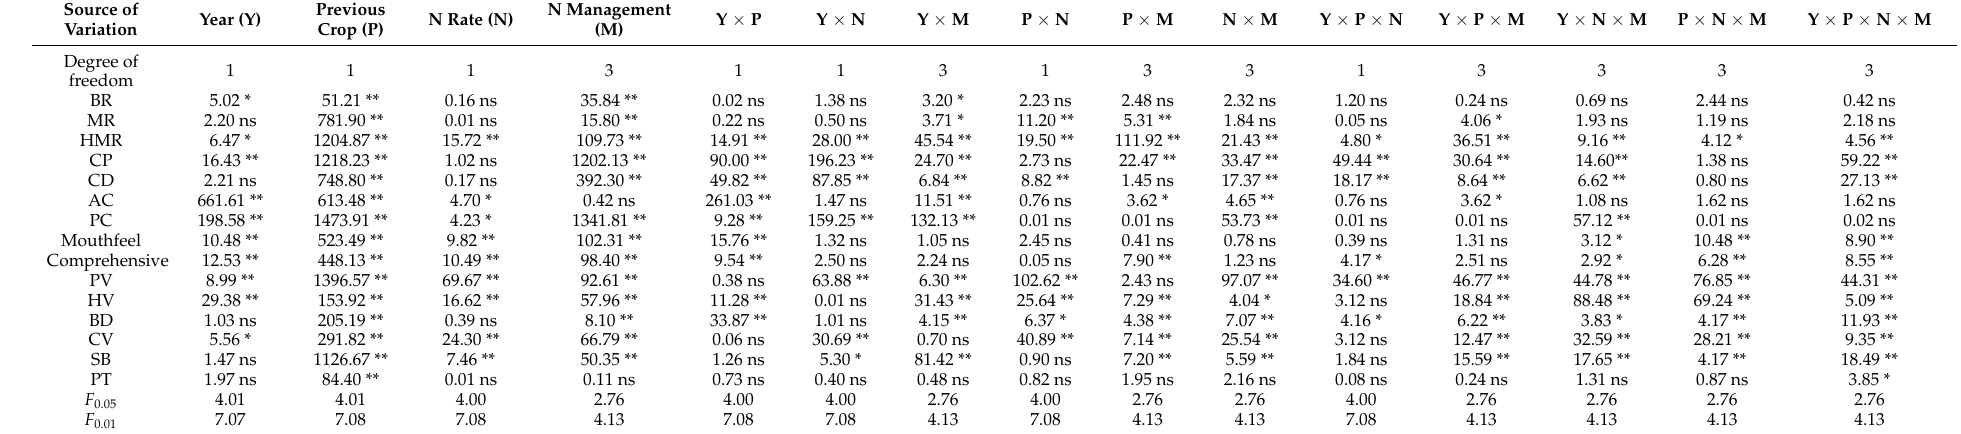
Table 2. Significance of variance estimates related to years (Y), previous crop (P), nitrogen rate (N), nitrogen management (M), and their interactions on rice grain quality traits. Source of